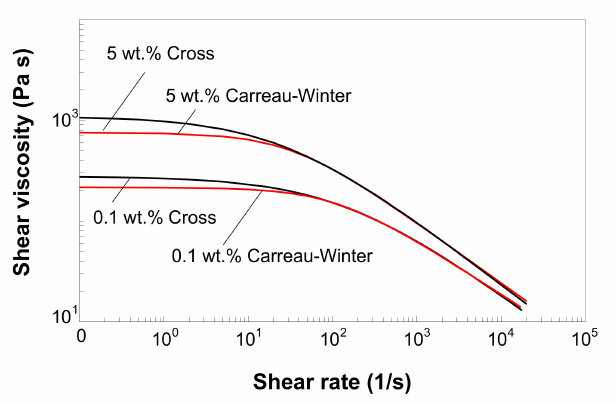
Figure 10. Comparison between the melt shear viscosity predictions by the Cross and Carreau–Winter models (master curves at 130 ◦ C reference